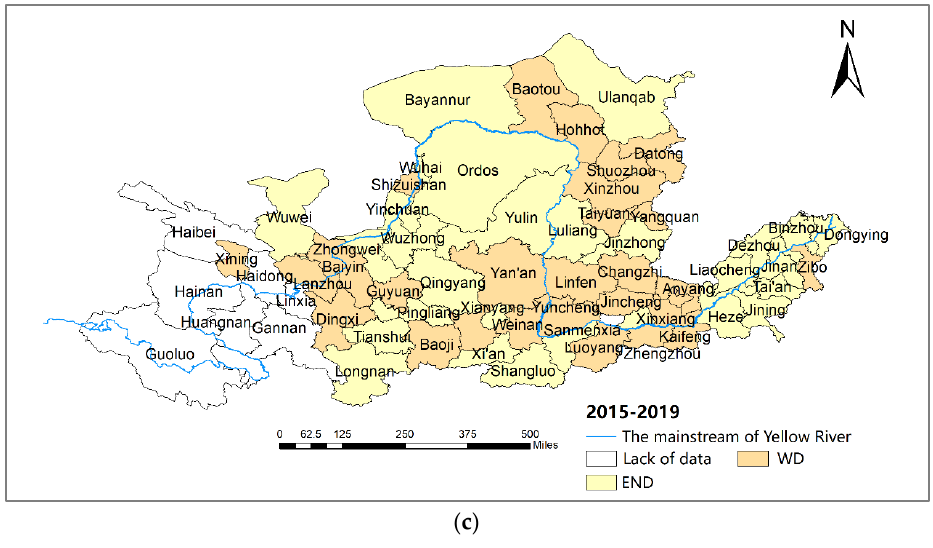
Figure 3. Decoupling states of cities in the YRB, 2006 – 2019. ( a ) Decoupling states of cities, 2006 – 2010. ( b ) Decoupling states of cities, 2010 – 2015. ( c ) Decoupling states of cities, 2015 – 2019.